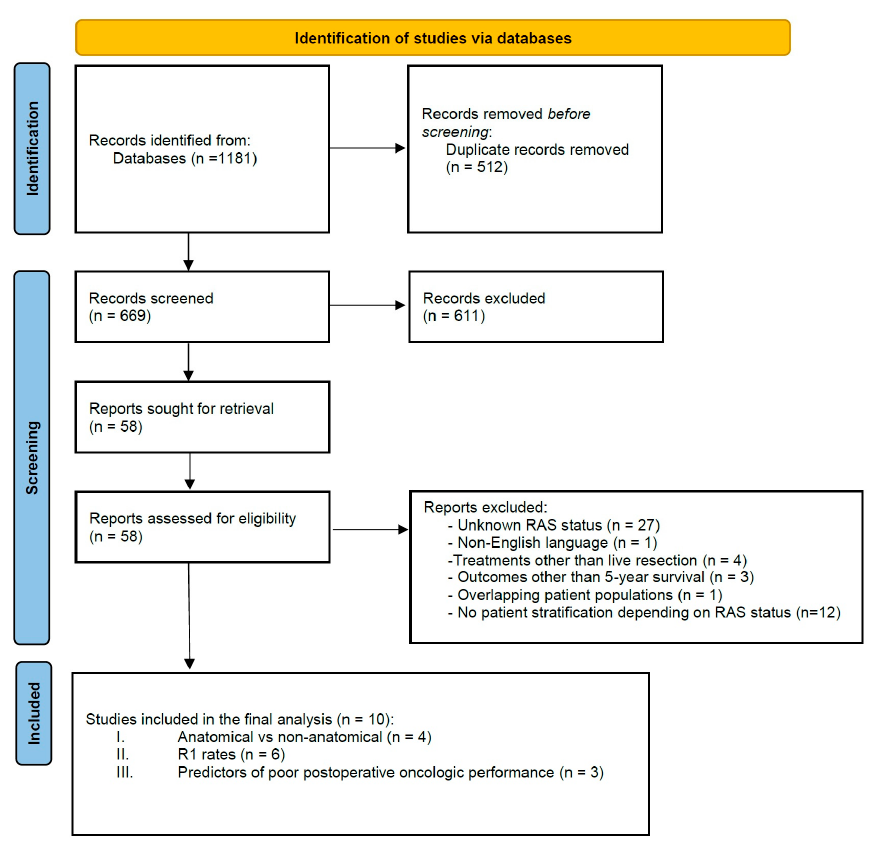
Figure 1. Prisma flowchart of study selection Figure 1. Prisma fl owchart of study selection process. Table 1. Baseline study characteristics and patient demographics.